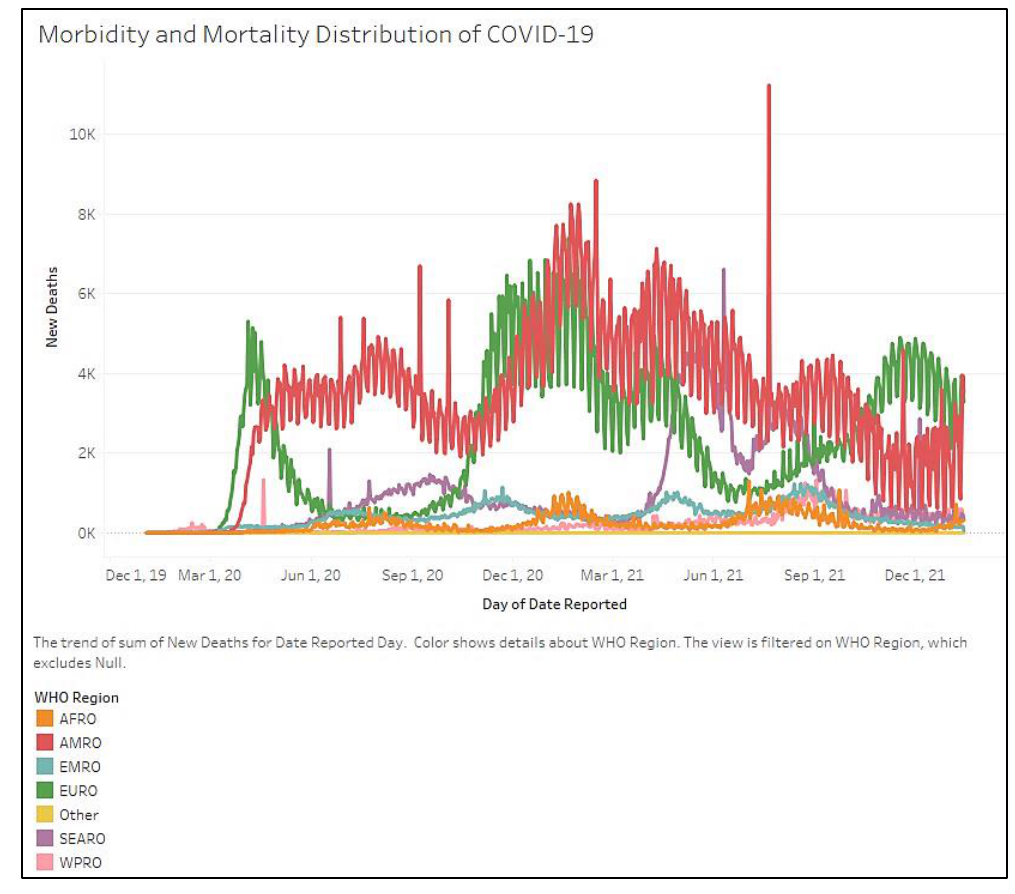
Figure 3. Time series plot showing the trend line of COVID-19 cases and deaths with time demonstrating multiple waves for different WHO